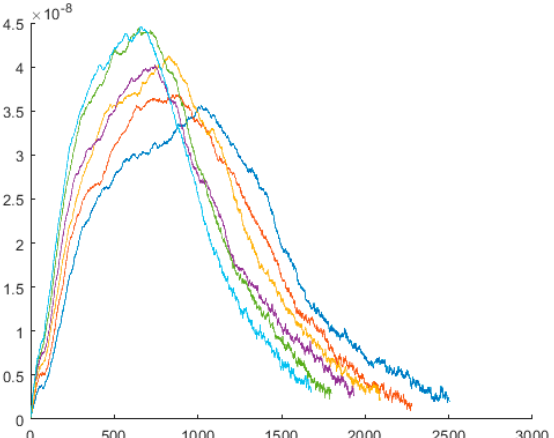
Figure 8. Snapshot of the crossing of functionalized CNT through the membrane. This figure shows the orientation of functionalized CNT while crossing through the membrane.